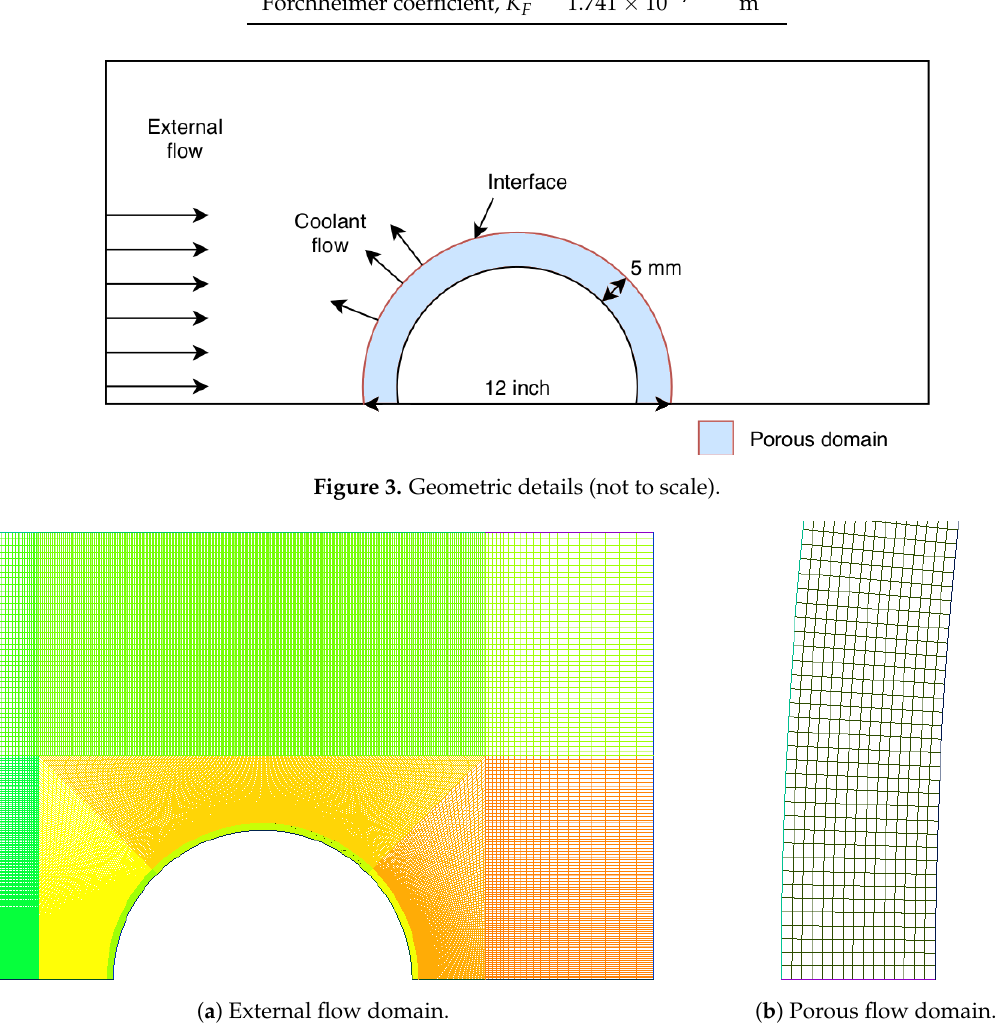
Figure 4. Meshing for individual domains with close-up of upstream mesh for porous